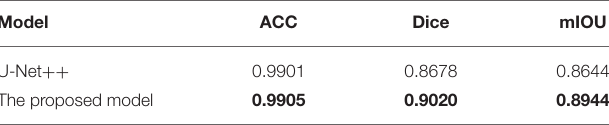
TABLE 1 | Quantitative performance indicators of two models. Model ACC Dice mIOU U-Net ++ 0.9901 0.8678 0.8644 The proposed model 0.9905 0.9020 0.8944